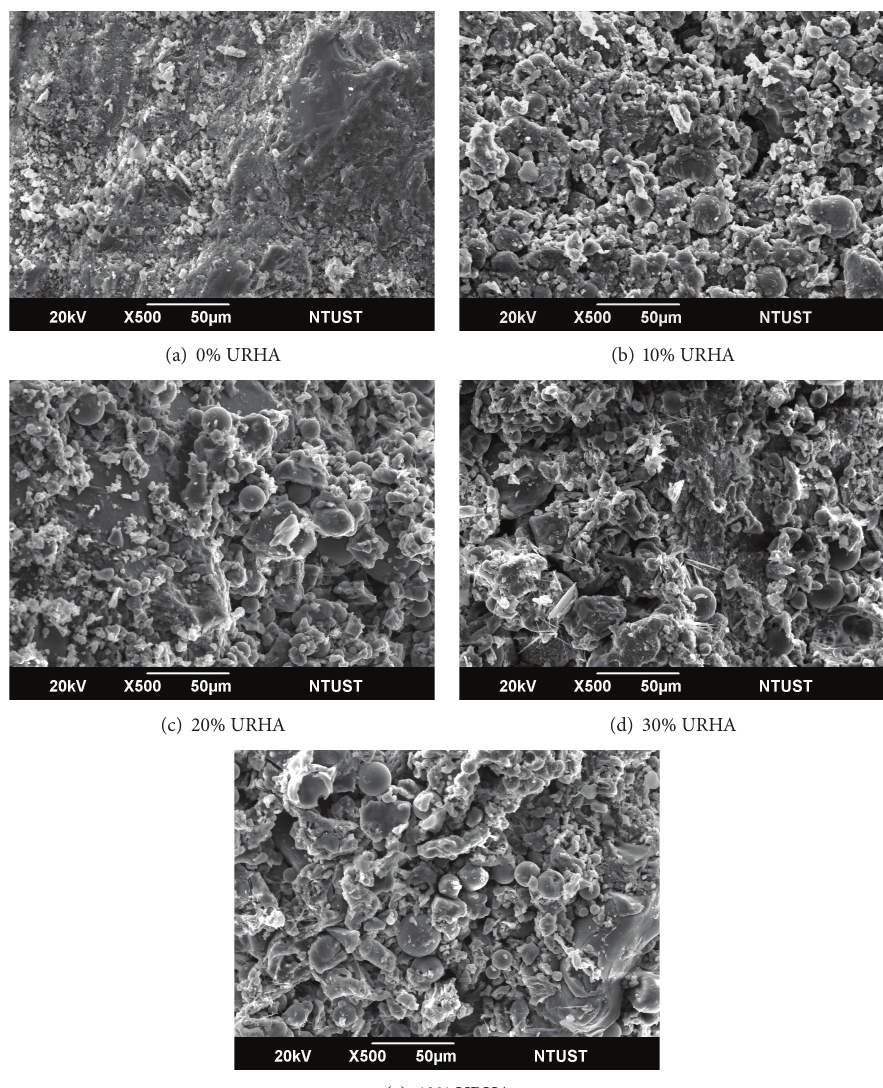
Figure 9: SEM micrographs of brick samples at various URHA replacement